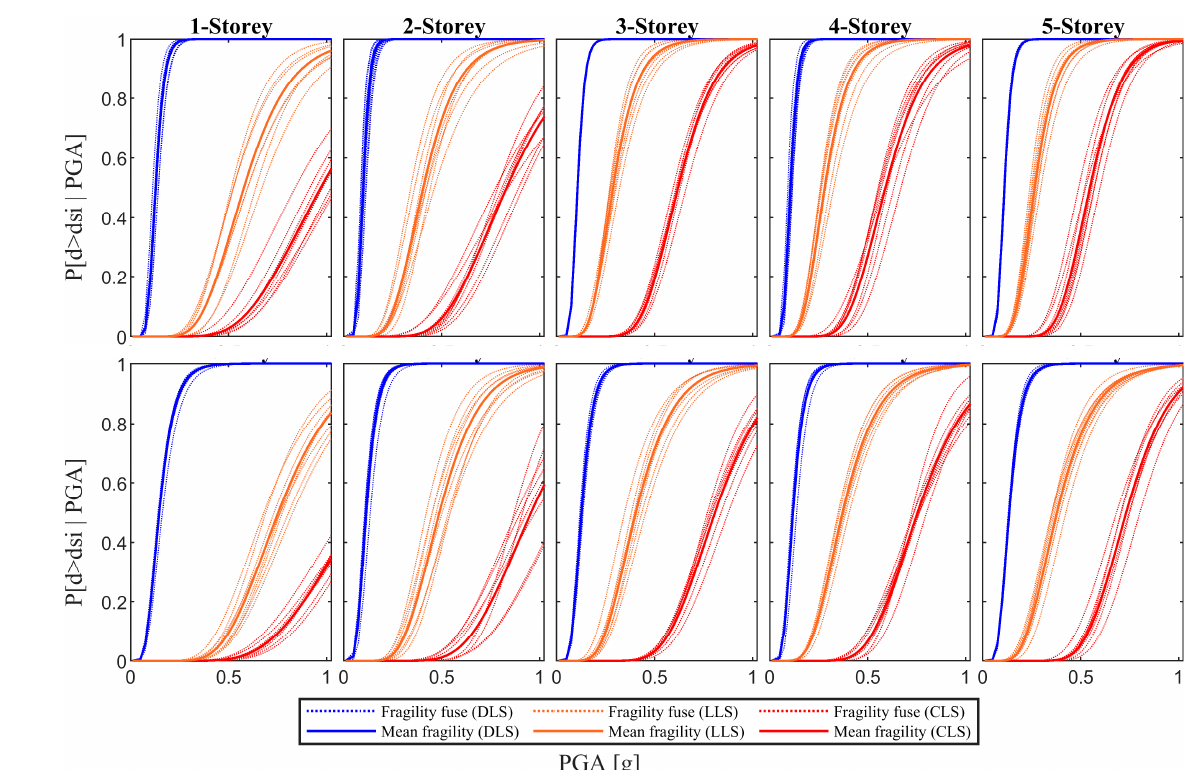
Figure 7. Resulting fragility curves for soil B; ( a ) Old; and ( b ) New. Figure 8. Resulting fragility curves for soil B; ( a ) Old; and ( b )